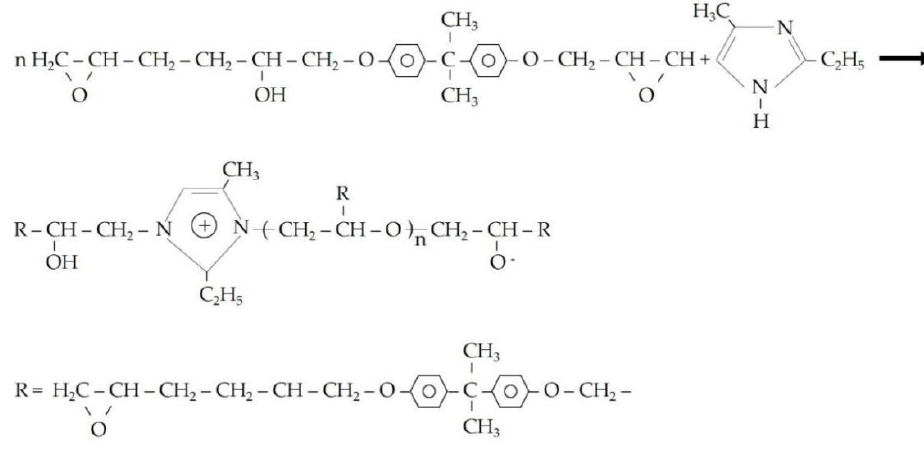
Figure 10. Chemical reaction process of epoxy resin and 2-ethyl-4-methylimidazole.